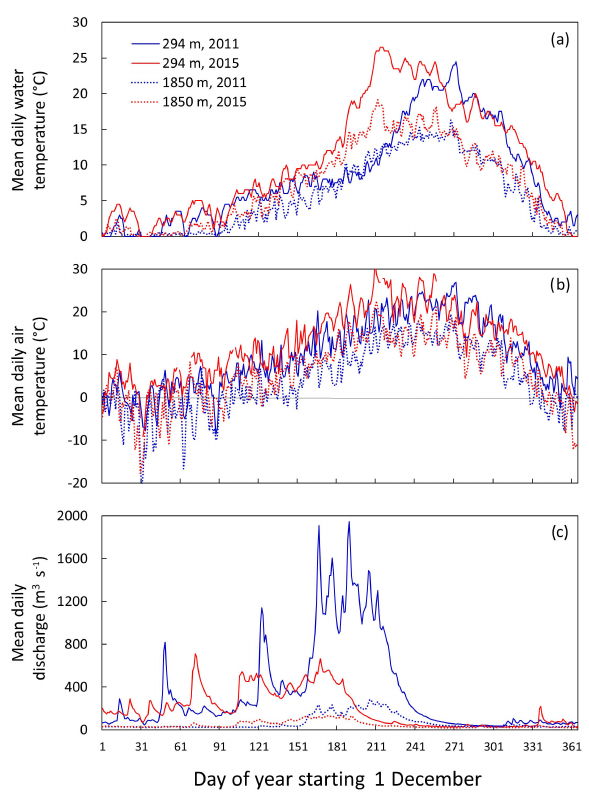
Figure 2. Annual cycle of mean daily water temperatures (a) , air temperatures (b) , and discharge (c) at a high-elevation site and a low-elevation site during 2 contrasting climate years. Discharge val- ues at the high-elevation site are multiplied by 10 for better visibil-